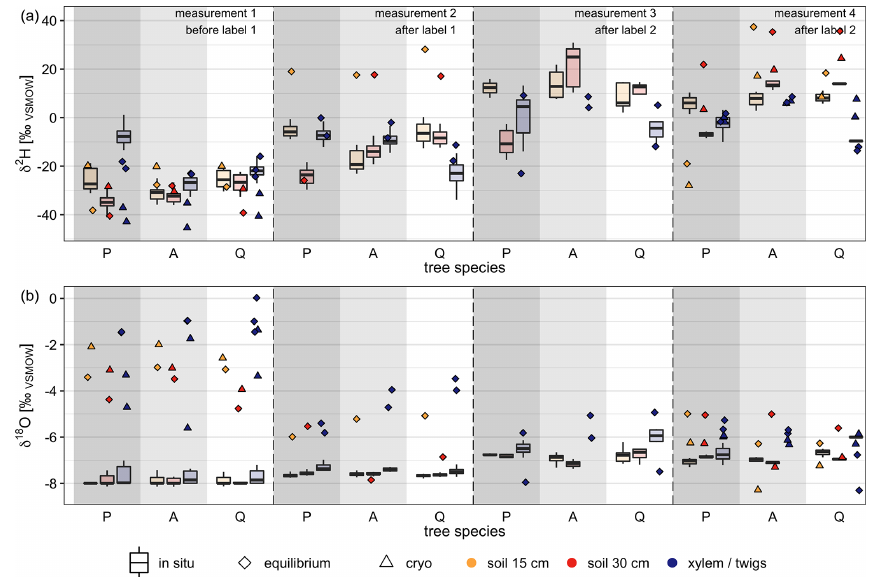
Figure 6. Comparison of destructive isotope measurement methods (direct water vapor equilibration = equilibrium, cryogenic vacuum extraction = cryo) with in situ stable water isotope measurements. Box plots (with median) represent in situ measurements for a 6d (on average 11 measurements, range 1 to 41 measurements) time frame around the destructive measurement campaigns. Dates of measurement campaigns and applied methods can be found in Table 4. Tree species on the x axis refer to P = Pinus pinea , A = Alnus incana and Q = Quercus suber . For reference, stable water isotope signature of labeling events, pre-experiment precipitation and pre-experiment irrigation can be found in Table